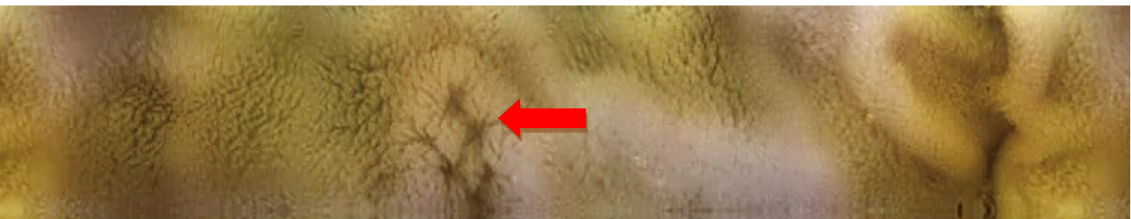
Figure 4. Video capsule enteroscopy. Normal porcine jejunum.